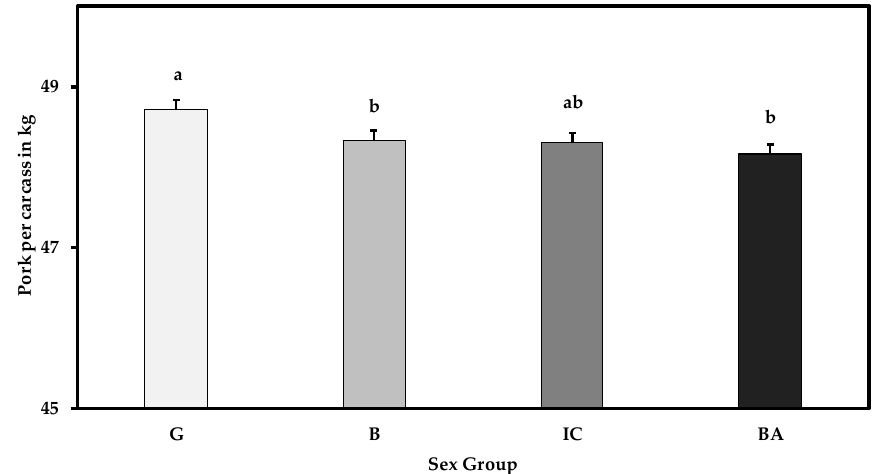
Figure 1. Amount of pork per carcass in kilograms from gilts (G; n = 15,226), boars (B; n = 16,922), immunocastrates (IC; n = 2815) and barrows (BA; n = 1977) based on AutoFOM III estimations (LSM ± SE). The amount of valuable pork (kg) between different sex groups with at least one identical letter shows no significant difference between them ( p < 0.05).